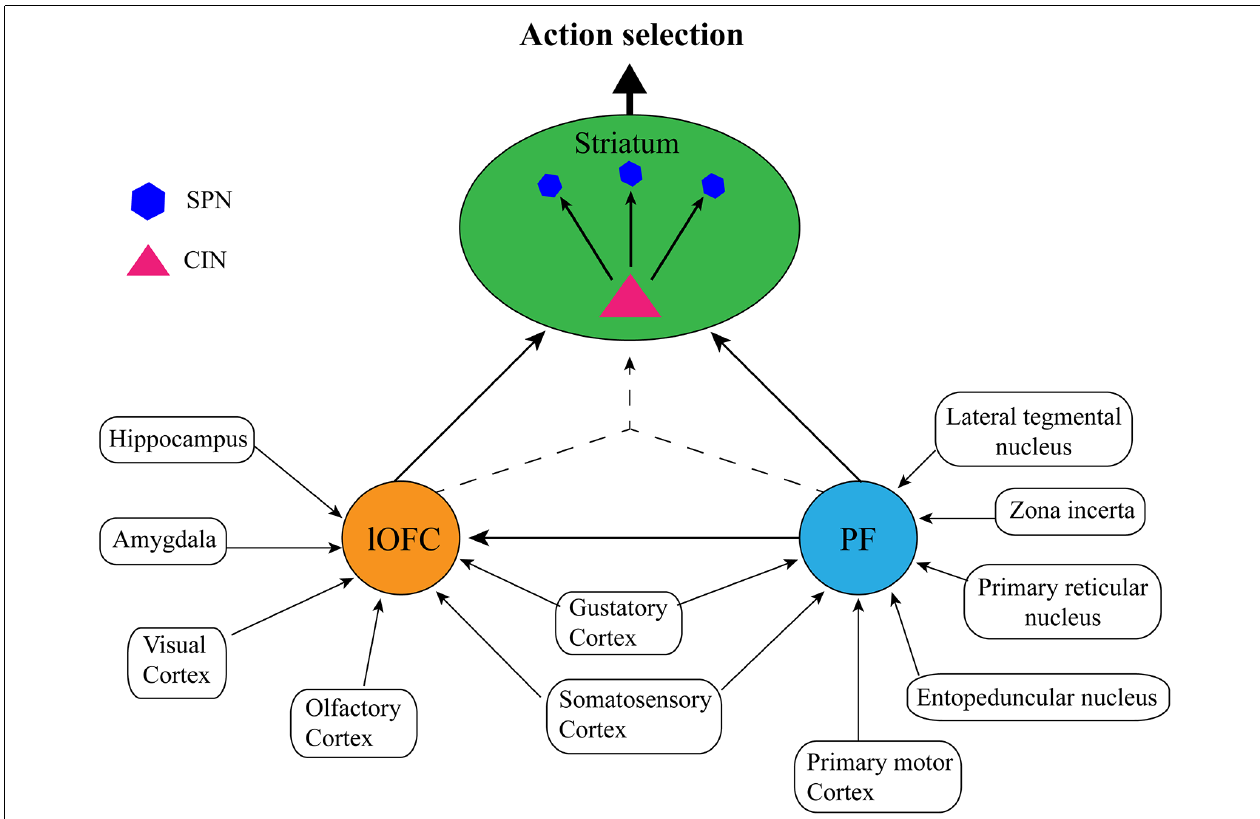
FIGURE 3 | Proposed simplified circuit of internal state representations: The lateral orbitofrontal cortex (lOFC) receives afferents conveying sensory information from visual, olfactory, gustatory, and somatosensory cortices, spatial and memory information from the hippocampus, and emotional information from the amygdala, the parafascicular nucleus of the thalamus (PF) receives sensory inputs from the gustatory cortex and somatosensory cortex, as well as action planning and execution, arousal/attentional information from the lateral tegmental nucleus, zona incerta, primary reticular nucleus, entopeduncular nucleus, and the primary motor cortex. Each structure performs independent integration of these inputs, and then either communicates directly via PF → lateral OFC → striatal cholinergic interneurons (CINs), or by converging lateral OFC → striatal CINs/PF → striatal CINs projections to form a cohesive, single internal state representation. Striatal CINs then modulate the striatal projection neurons (SPNs) to influence action selection according to the internal